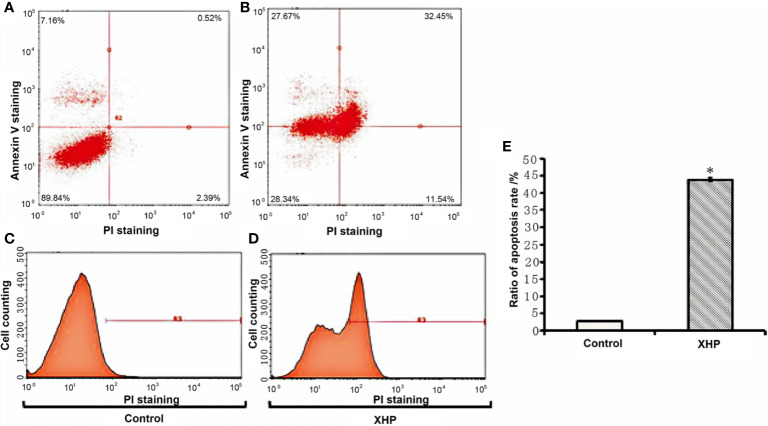
Effect of XHP on apoptosis of MD-MB-231 cells (A, C) are apoptotic maps of a random set of three duplicate wells in the control group; (B, D) are apoptotic maps of a random set of three duplicate wells in the XHP group; (E) is a histogram of the proportion of apoptotic cells in the two groups, compared with the control group; *P < 0.01).